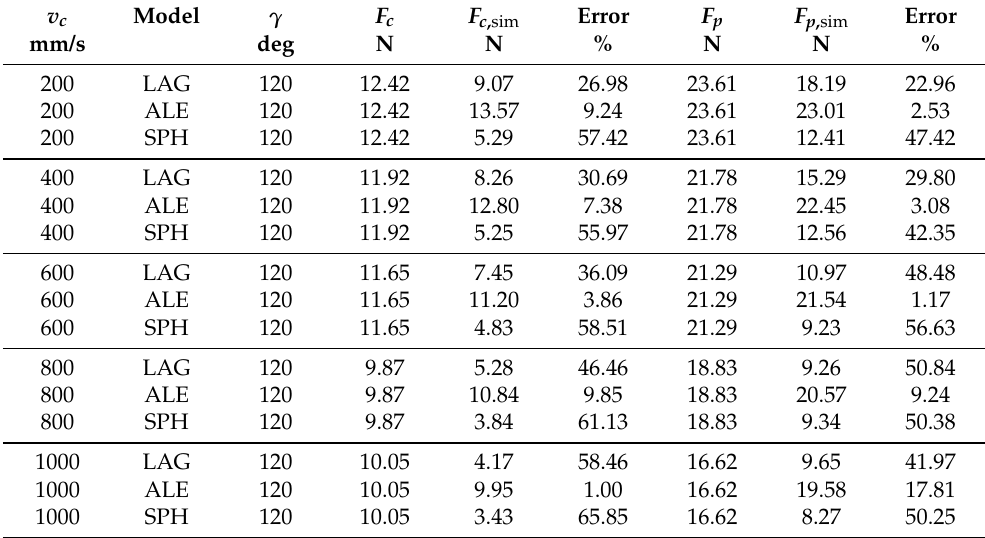
Table 4. Comparison of measured cutting and passive force in a single grit scratch experiment with different numerical methods with an indenter cone angle of 120 ◦ . In the table, F c represents the experimental measured cutting force, F p represents the experimental measured passive force, F c ,sim represents the predicted cutting force, and F p ,sim represents the predicted passive